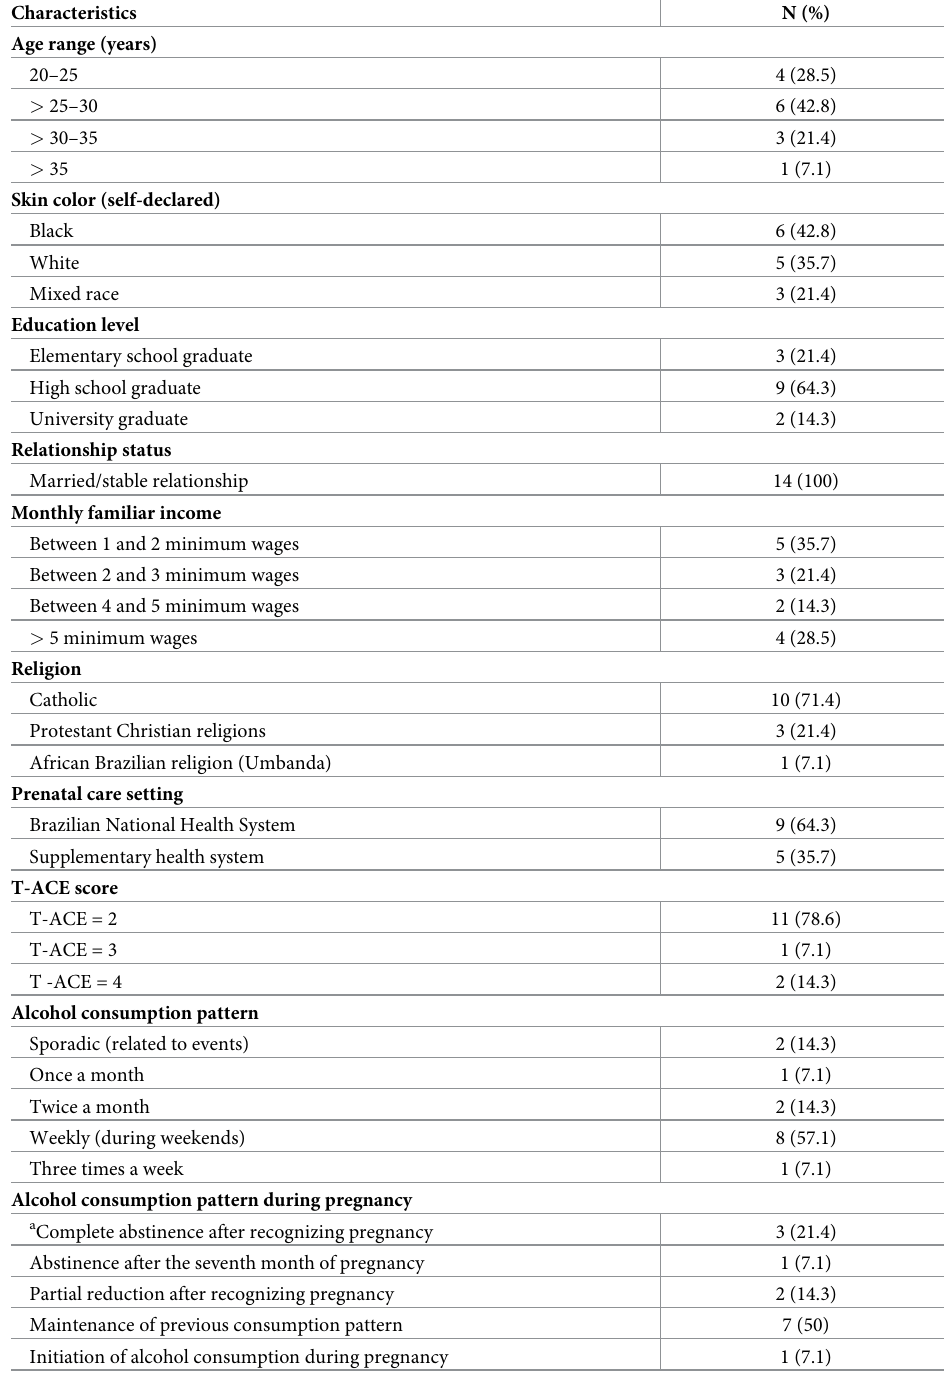
Table 1. Participants’ sociodemographic